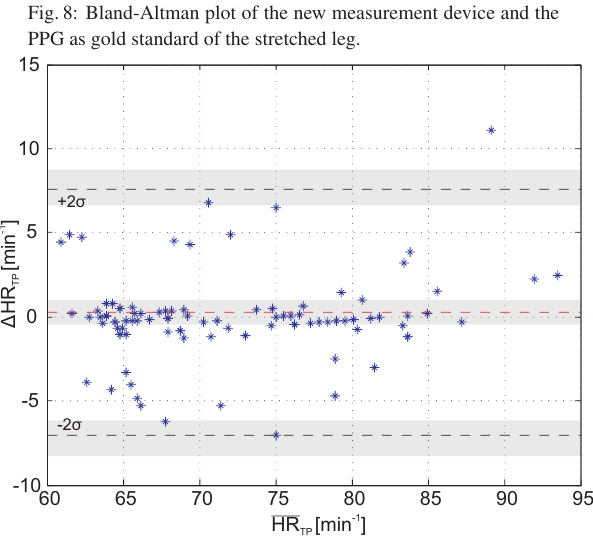
Fig.9: Bland-Altman plot of the new measurement device and the PPG as gold standard of the bent